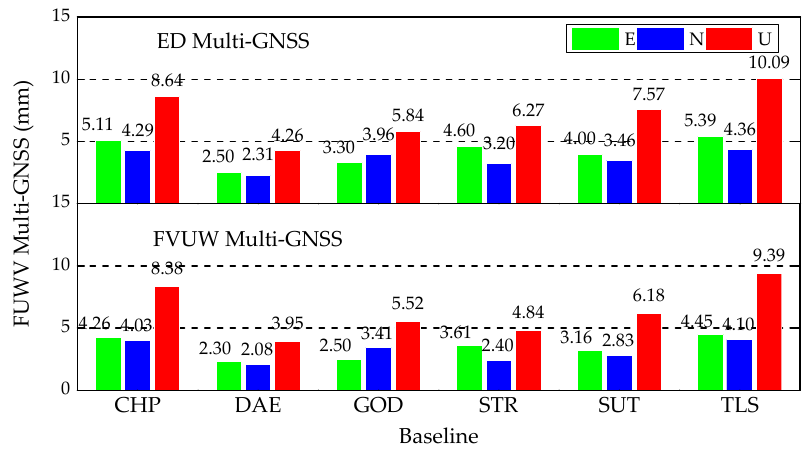
Figure 10. RMSs of ED Multi-GNSS ( top ) and FVUW Multi-GNSS ( bottom ) from DoY 201 to 230 in 2019.